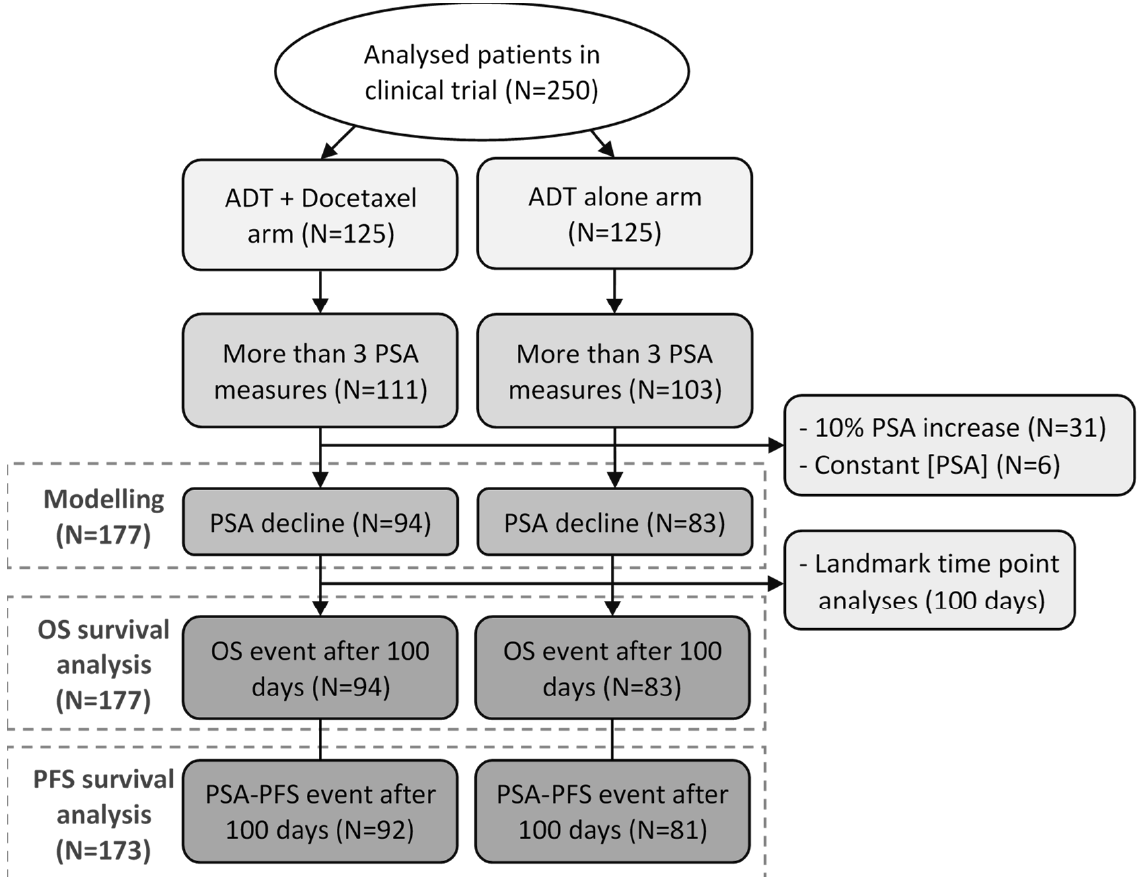
Figure 2. Flowchart of patients selected for the modeling and survival analyses. Patients’ selection included in the present study.